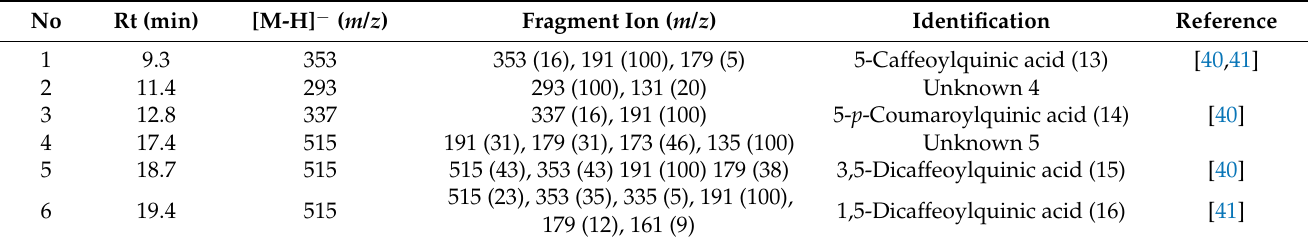
Table 4. Peak assignment for the HPLC–MS/MS analysis of the methanol extracts of Ferula drudeana